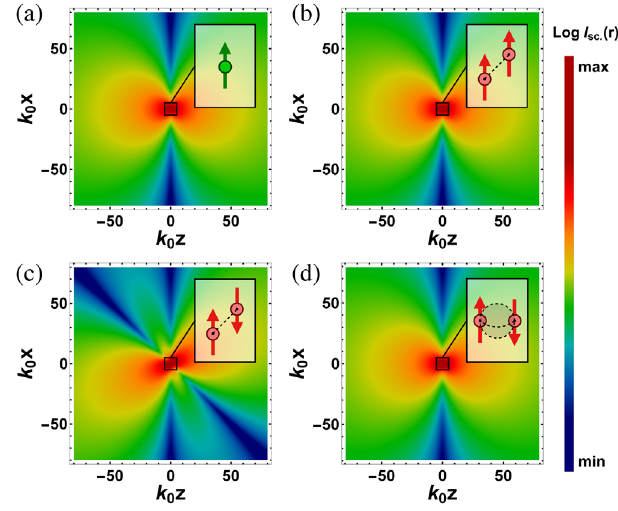
FIG. 5. Radiation pattern of a single dipole, compared to that of two in-phase or out-of-phase dipoles. (a) Given an isolated dipole ˆ x , which is placed at d of fixed dipole amplitude d 0 and direction ρ ¼ 0 and radiates light at the frequency ω 0 , we plot the intensity ¯¯ G r Þ ¼ j μ ω 2 of the radiated field I ð r ; ω 0 Þ · d j 2 = ð 2 μ 0 c Þ in the 0 0 sc ð ˆ x − ˆ z plane, with the value indicated in the color bar. (b,c) P ¯¯ G r Þ ¼ j μ ω 2 Radiation pattern I ð r − r j ; ω 0 Þ · d j j 2 = 0 0 sc ð j ¼ 1 ; 2 ð 2 μ 0 c Þ for two near-positioned dipoles of fixed amplitude d 0 and direction ˆ x , oscillating either in phase (b) or out of phase (c) with one another (i.e., d 1 ¼ (cid:4) d 2 ¼ d 0 ˆ x ), and placed at two out-of-phase dipoles averaged over all possible interatomic orientations, keeping the mutual distance j ρ 1 − ρ 2 j ¼ 0 . 2